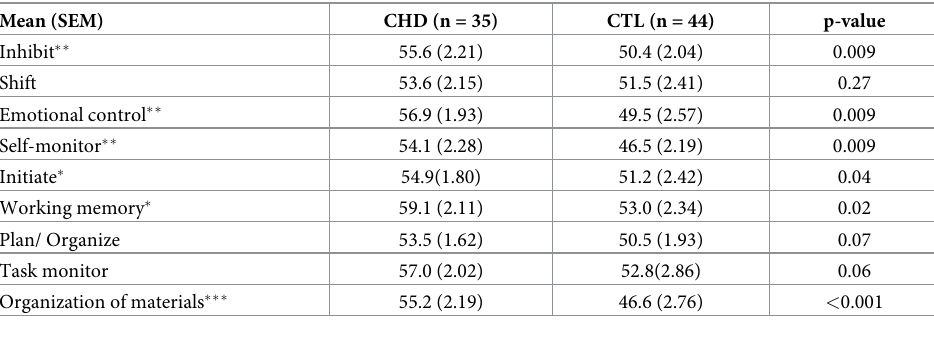
Table 2. BRIEF-A scales